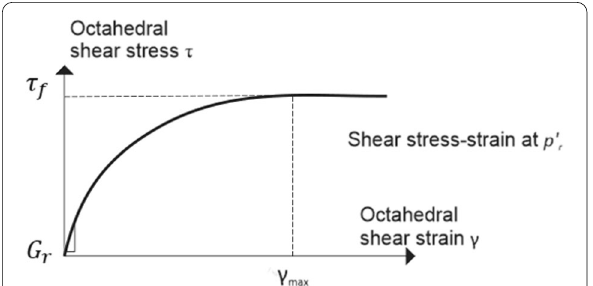
Fig. 5 Stress–strain behaviour of PIMY model